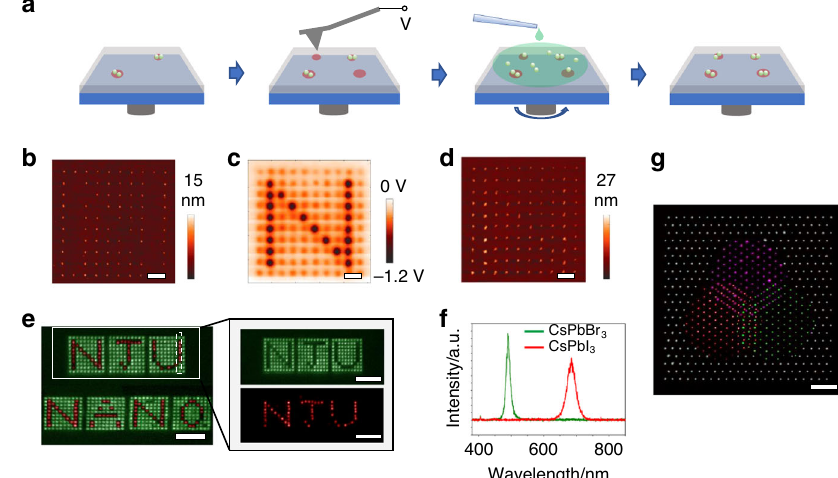
Fig. 2 Color printing of multiple functional NPs. a Schematic illustration of the assembly of different NPs by repeating the EFASP process. b AFM height image after printing the fi rst cycle of 12-nm CsPbBr 3 QDs as a hollow N pattern. Scale bar, 1 μ m. c Electrical potential image after writing the second charge pattern N. Scale bar, 1 μ m. d AFM height mapping of the binary pattern after depositing the second cycle of CsPbI 3 QDs. Scale bar, 1 μ m. e PL image of the dual-color pattern and its corresponding images with green and red bandpass fi lters (marked by the white solid rectangle). No spatial overlap was found between the green and red areas, indicating no cross-contamination occurs. Scale bar, 5 μ m. f PL spectra of two kinds of QDs on one pixel corresponding to ( e ). g pseudo-color image captured by the dark- fi eld microscopy of a color pattern, which is composed of four types of NPs with 606 pixels. The white color is created by 15-nm γ -Fe 2 O 3 NPs, while the magenta, green and red colors are produced by NaYF 4 :Yb,Er, CsPbBr 3 and CdSe@ZnS NPs, respectively. Scale bar, 10 μ m.